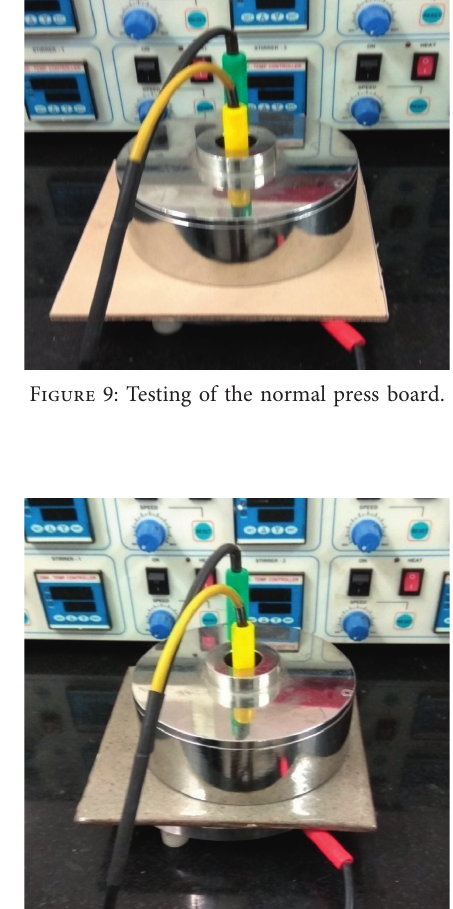
Figure 10: Testing of the press board coated with epoxy coating.